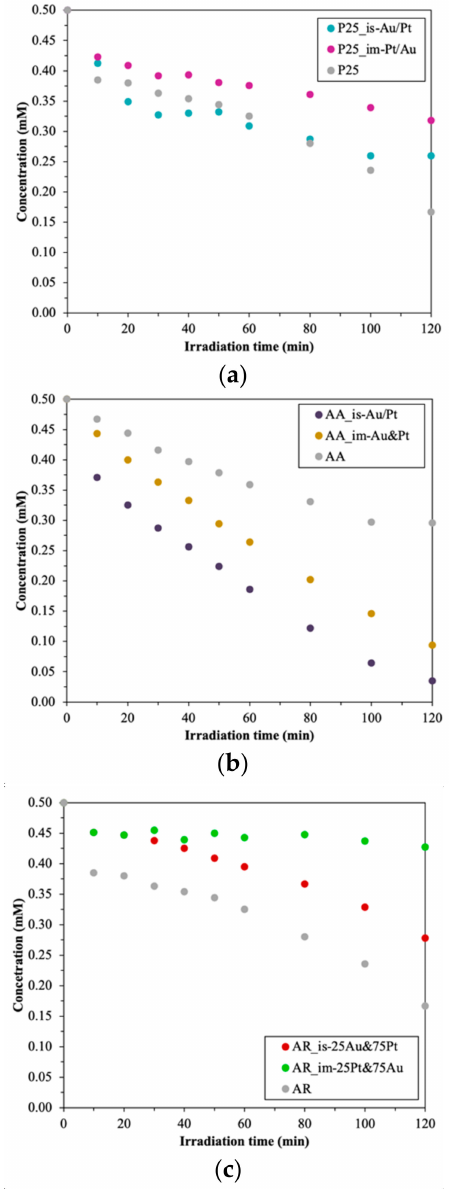
Figure 9. Degradation curves of salicylic acid—( a ) P25 and it is composites, ( b ) AA and it is com- posites, and ( c ) AR, and it is composites—the AA-based composites achieved better photocatalytic activity than the base